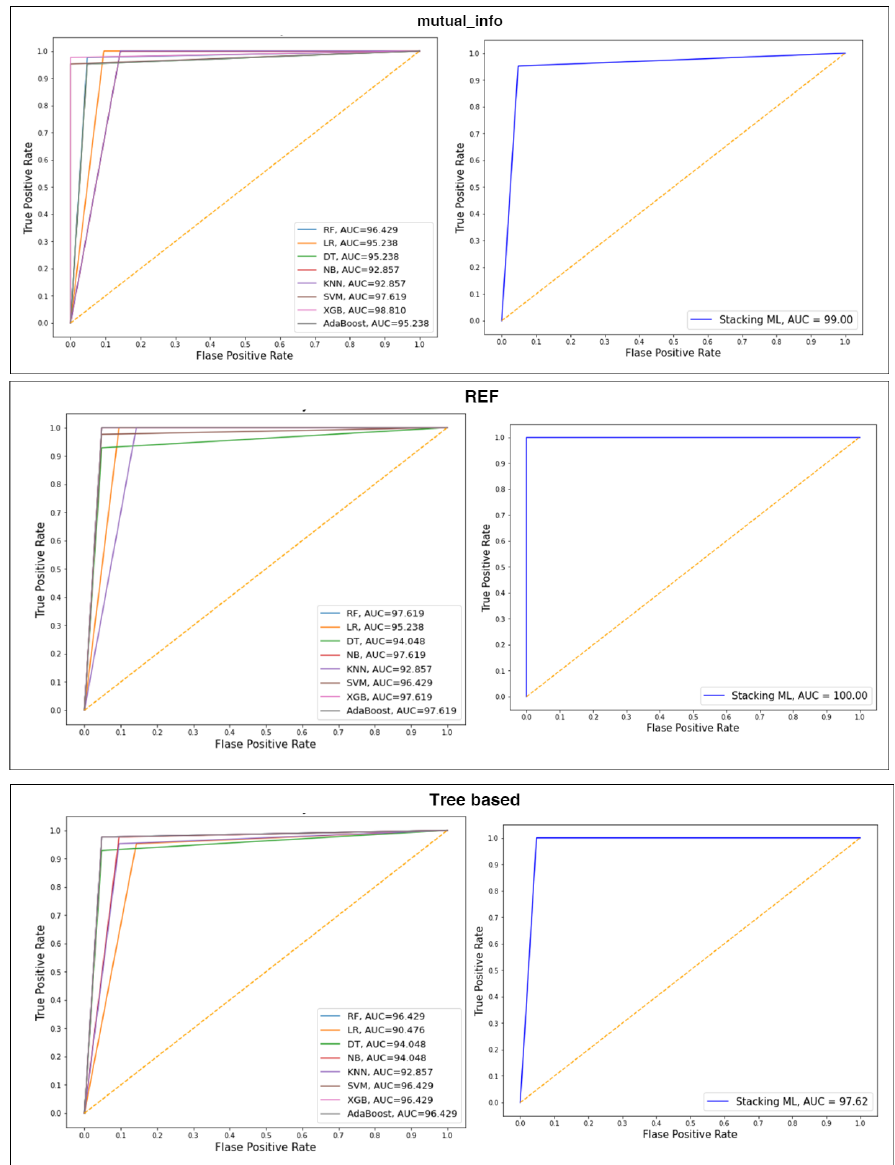
Figure 6. ROC curves of splitting